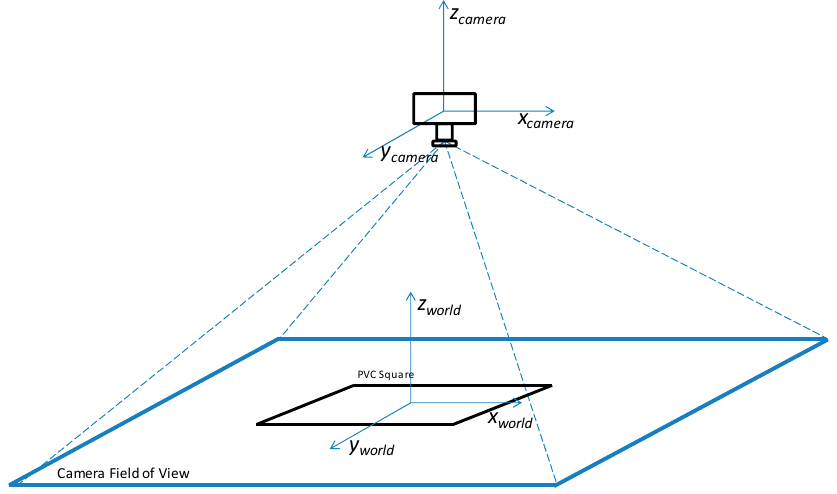
Figure 2. sUAV camera frame and world frame relationship.